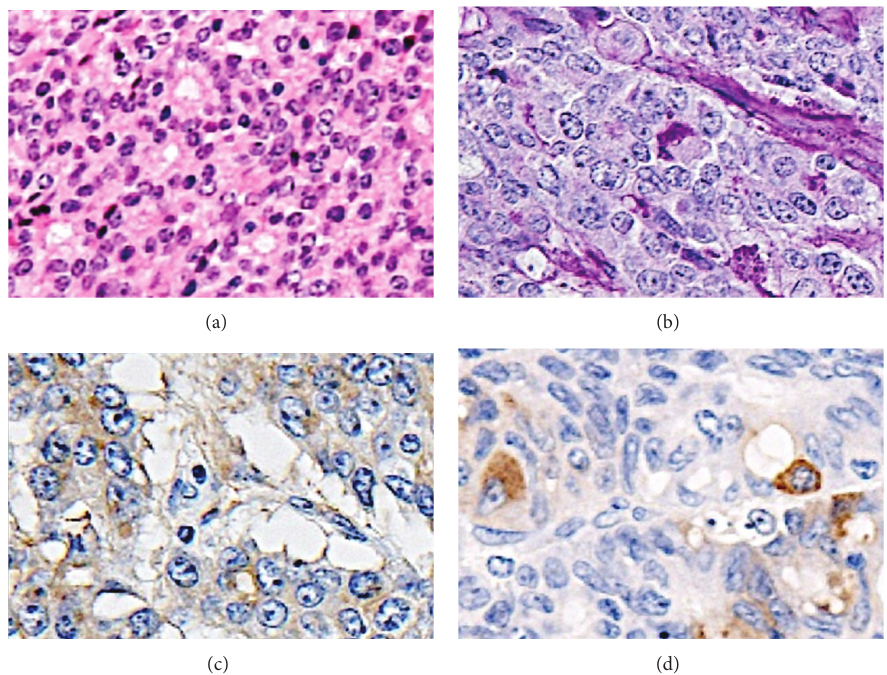
Figure 4: Microscopic findings of the resected tumor. (a) Acinar pattern consisting of well-formed acinar structures (hematoxylin and eosin staining, × 200); (b) a positive periodic acid-Schiff reaction followed diastase digestion within the cytoplasm and apical cytoplasmic tips ( × 200); tumor cells were focally positive for (c) lipase and (d) trypsin ( × 200).